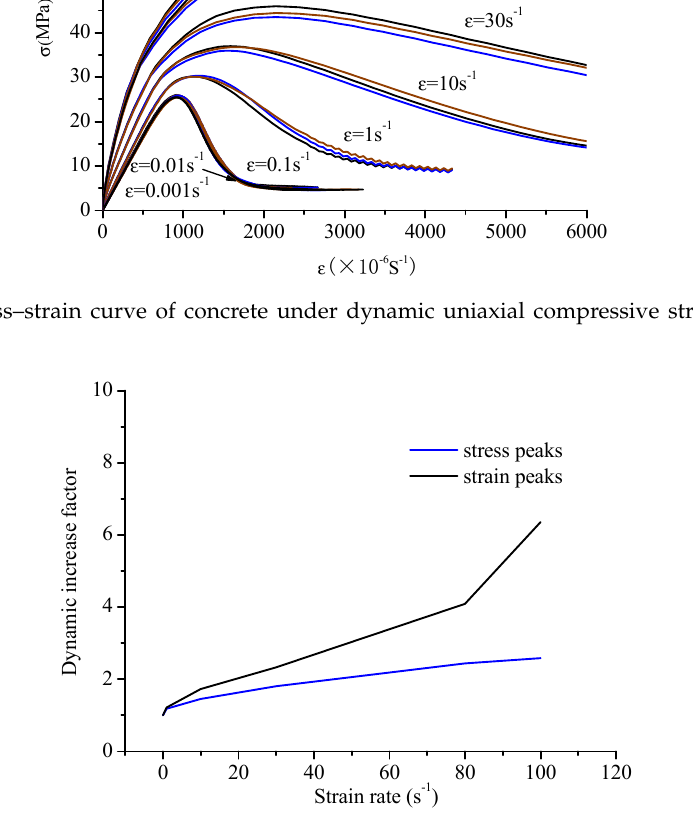
Figure 10. The comparison of the peak values of strain and stress.